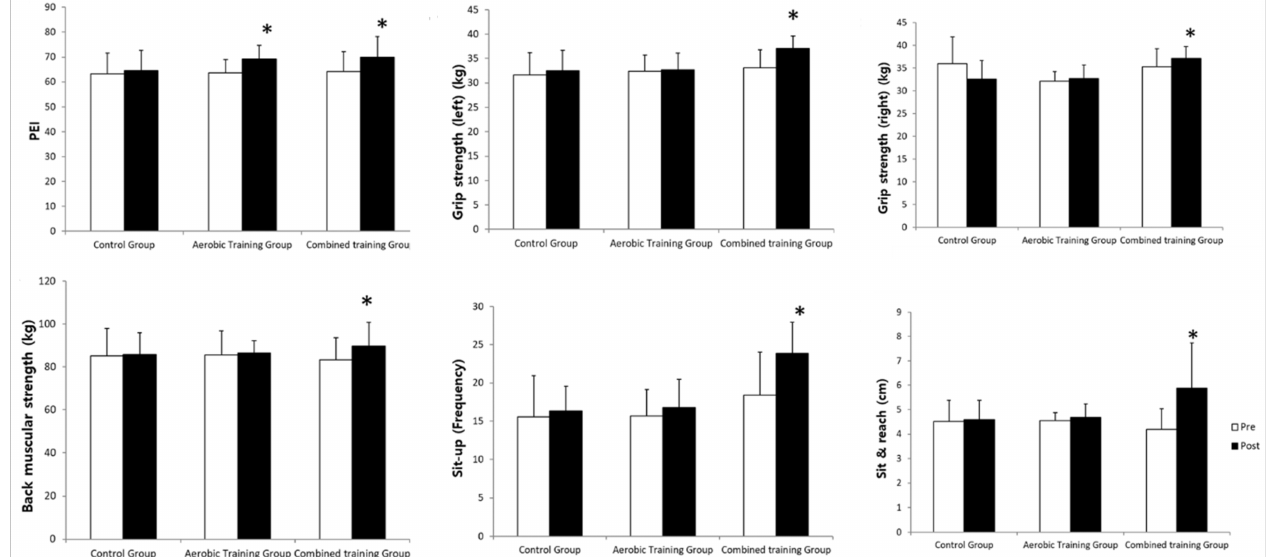
Figure 3. Change of health-related physical fitness after 12 week exercise training. 2-way repeated ANOVA for group and time: PEI, Group F 2,51 = 4.131 ( p < 0.05), Time F 1,51 = 5.129 ( p < 0.05), G × T F 2,51 = 9.167 ( p < 0.05); Grip strength (Left), Group F 2,51 = 4.123 ( p < 0.05), Time F 1,51 = 5.661 ( p < 0.05), G × T F 2,51 = 5.178 ( p < 0.05); Grip strength (Right), Group F 2,51 = 3.987 ( p < 0.05), Time F 1,51 = 4.890 ( p < 0.05), G × T F 2,51 = 6.617 ( p < 0.05); Back muscular strength, Group F 2,51 = 4.002 ( p < 0.05), Time F 1,51 = 4.919 ( p > 0.05), G × T F 2,51 = 9.617 ( p < 0.05); Sit-up, Group F 2,51 = 5.977 ( p < 0.05), Time F 1,51 = 4.657 ( p < 0.05), G × T F 2,51 = 9.111 ( p < 0.05); Sit & reach, Group F 2,51 = 6.134 ( p < 0.05), Time F 1,51 = 5.919 ( p < 0.05), G × T F 2,51 = 8.268 ( p < 0.05). *: p < 0.05 vs. Pre-test. *: p < 0.05 vs.